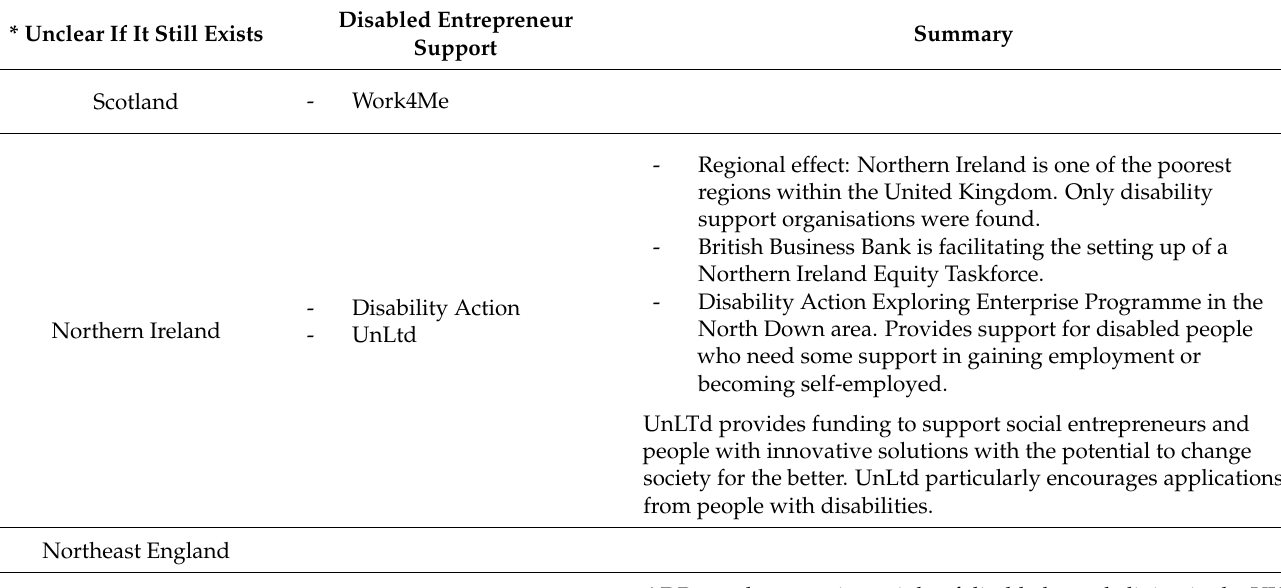
Table 1. Geographical distribution of networks and organisations that support disabled